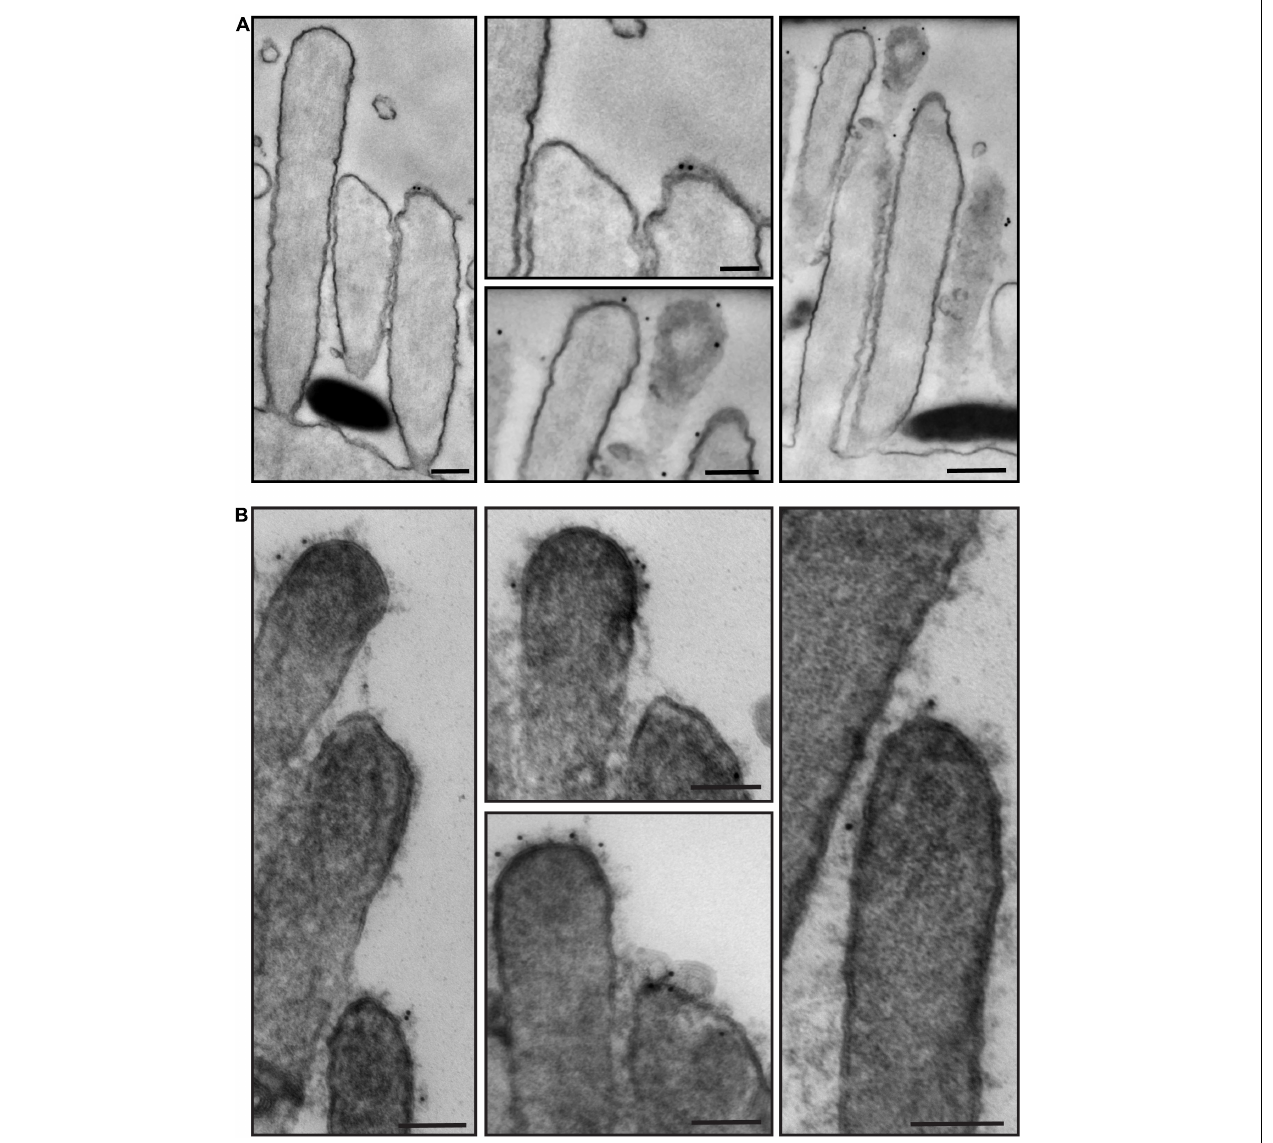
FIGURE 7 | Representative immunogold transmission electron micrographs of OHC hair bundles in neonatal (P4) wild-type mouse cochlea. Samples immunostained with anti-PKHD1L1 primary antibody and gold-conjugated secondary antibody. Gold beads (10 nm) localize near the tips of stereocilia. (A,B) Were prepared in parallel, however in (B) post-staining with uranyl acetate and lead citrate significantly increased contrast of stereocilia cores and surface coat. (A,B) Samples were imaged with a JEOL 1200EX microscope operating at 80 kV. Scale bars: (A) 200 nm; (B) 100